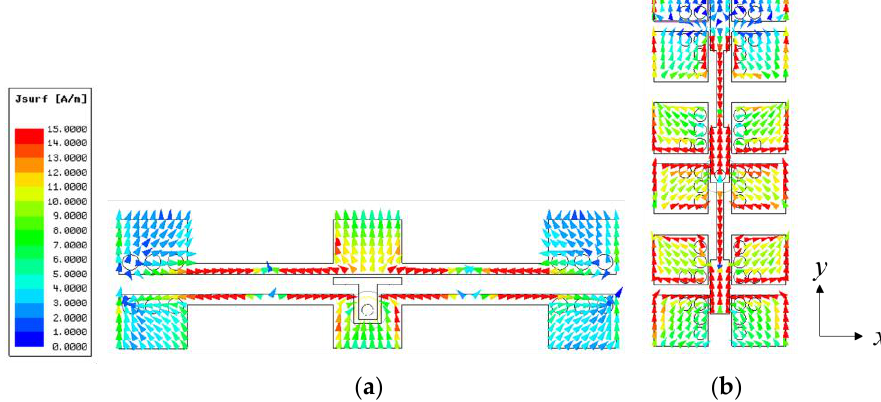
Figure 2. Current distribution of ( a ) the 1-D 3 × 1 interconnected ME dipole array along the x-direction and ( b ) the 1-D 1 × 3 interconnected ME dipole array along the y-direction.